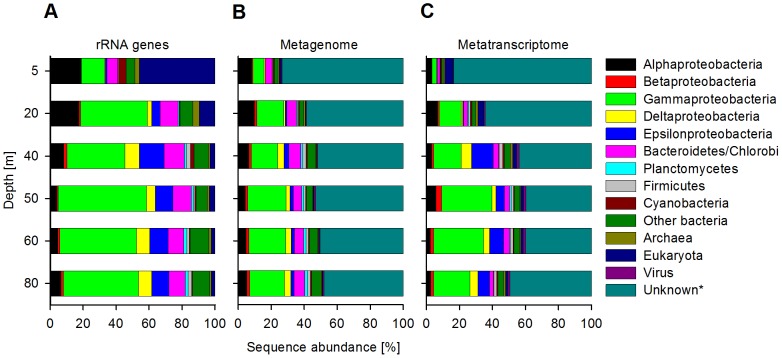
Vertical distribution of taxonomic assignments.Shown on either domain, phylum or class level. (A) rRNA genes in percent of all rRNA genes (5,923 sequences). (B) Metagenomic sequences in percent of all metagenomic sequences (1,882,842 sequences, excluding rRNA genes). (C) Metatranscriptomic sequences in percent of all metatranscriptomic sequences (421,528 sequences, excluding rRNAs). ‘Other Bacteria’ include Acidobacteria, Actinobacteria, Aquificae, Chlamydiae, Chloroflexi, Deferribacteres, Deinococcus-Thermus, Dictyoglomi, Elusimicrobia, Fibrobacteres, Fusobacteria, Gemmatimonadetes, Lentisphaerae, Nitrospirae, Spirochaetes, Synergistetes, Tenericutes, Thermotogae and Verrucomicrobia. *Sequences with no significant match against the non-redundant database of NCBI or sequences with a match that lacks taxonomic information.